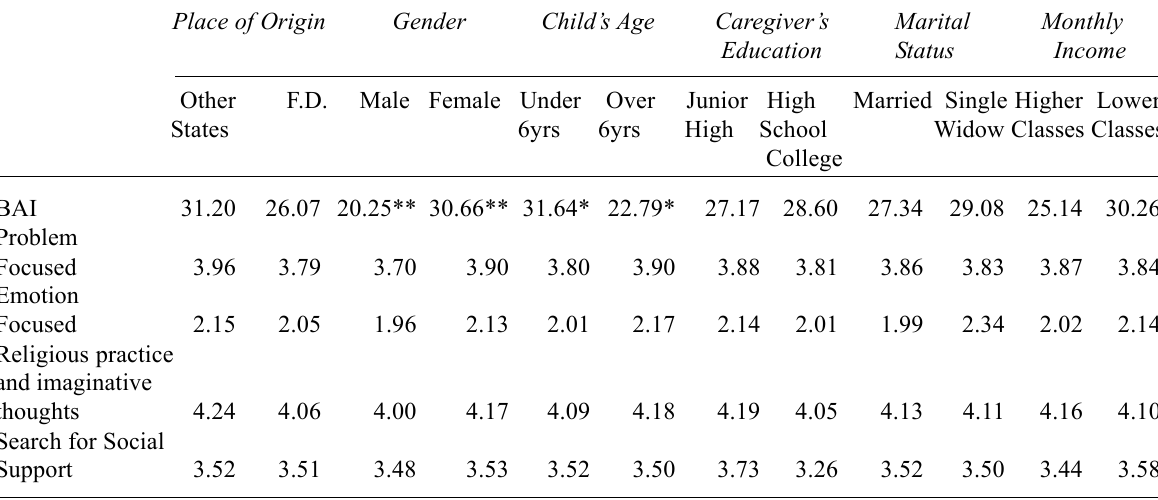
Results from Student’s t-Test: Anxiety and Coping Averages and Sociodemographic Characteristics